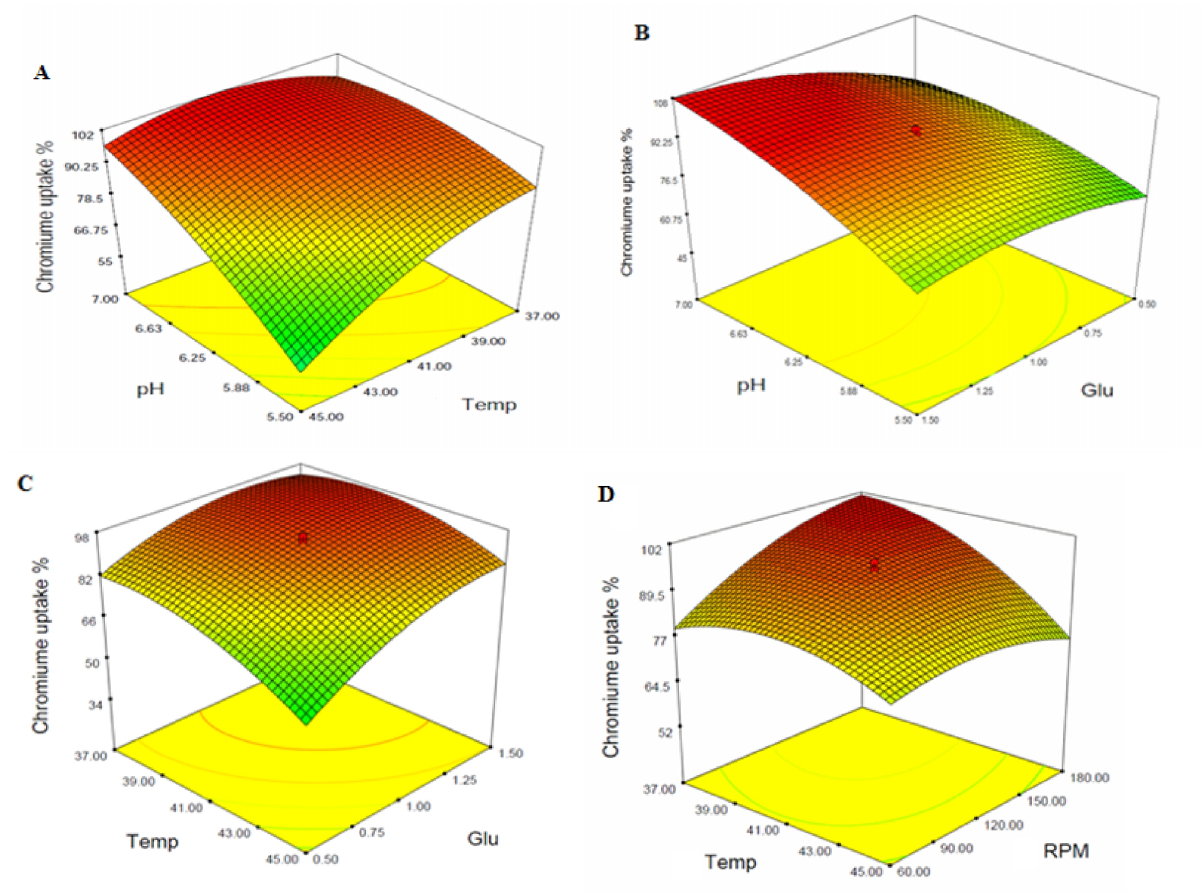
Fig. 6. Design-Expert plot. 3D surface plot of chromium removal efficiency showing (A) the interacting effect of pH and temperature at [glucose] and shaking rate of constant. (B) The interacting effect of pH and [glucose] at temperature and shaking rate of constant. (C) Interacting effect of temperature and [glucose] at pH and shaking rate of constant. (D) Interacting effect of temperature and RPM at pH and [glucose] of